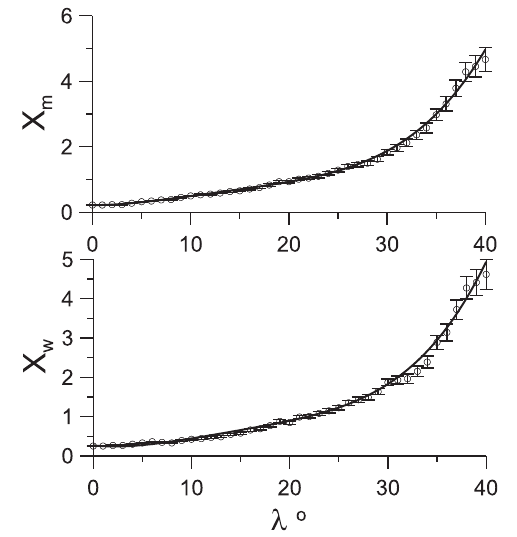
Fig. 7. Mean value X m and variance X w from Eq. (18) are shown by black color, while spacecraft observations are shown by